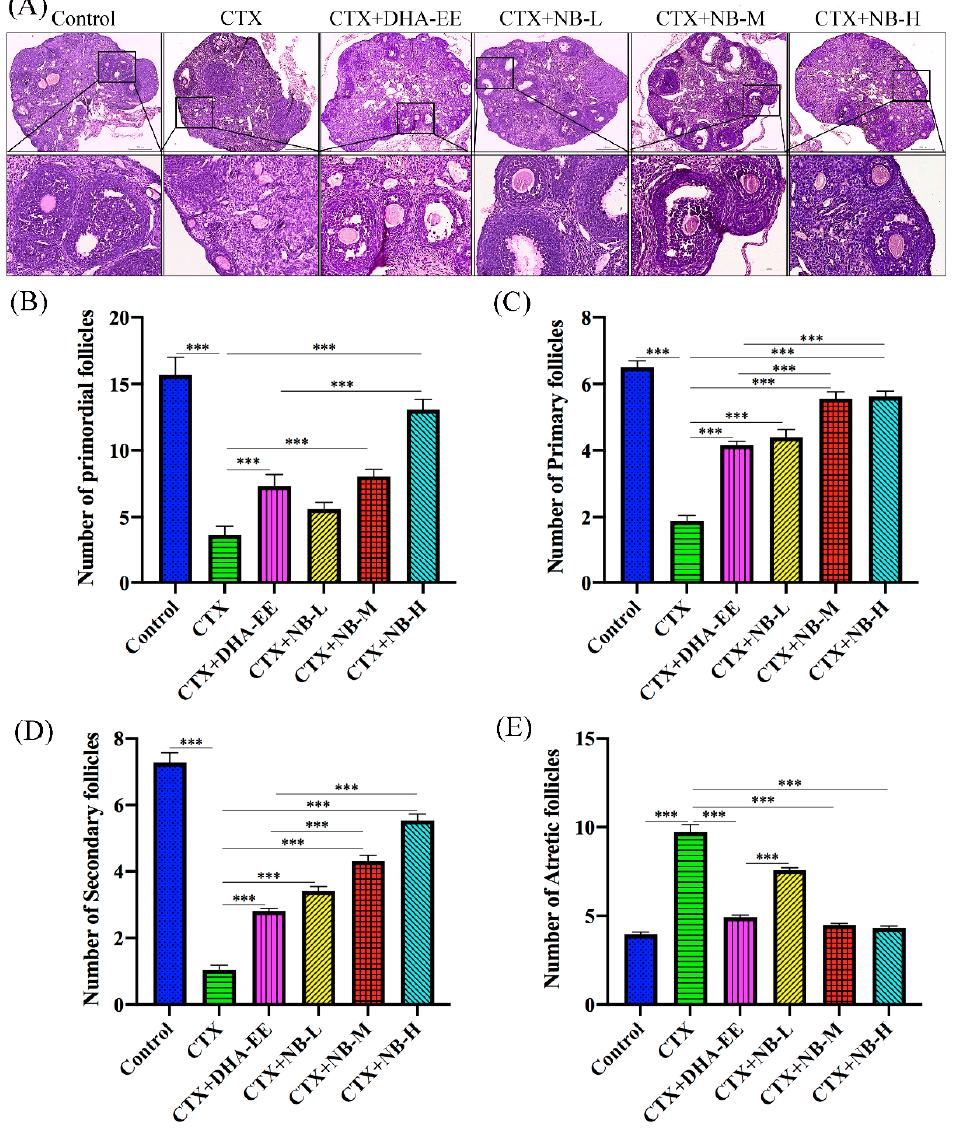
Figure 3. Effect of DHA-EE and NB-DHA on the development of follicles. Follicles after H&E staining ( A ). Magnification 100 × and 400 × . Scale bar: 250 and 50 µ m. Number of different follicles: primordial follicles ( B ), primary follicles ( C ), secondary follicles ( D ), and atretic follicles ( E ). *** p <